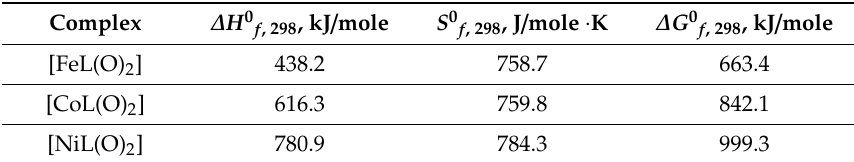
Table 2. Standard thermodynamic parameters of formation ( ∆ H 0 f , 298 , S 0 f , 298 and ∆ G 0 f , 298 ) for the complexes of Type